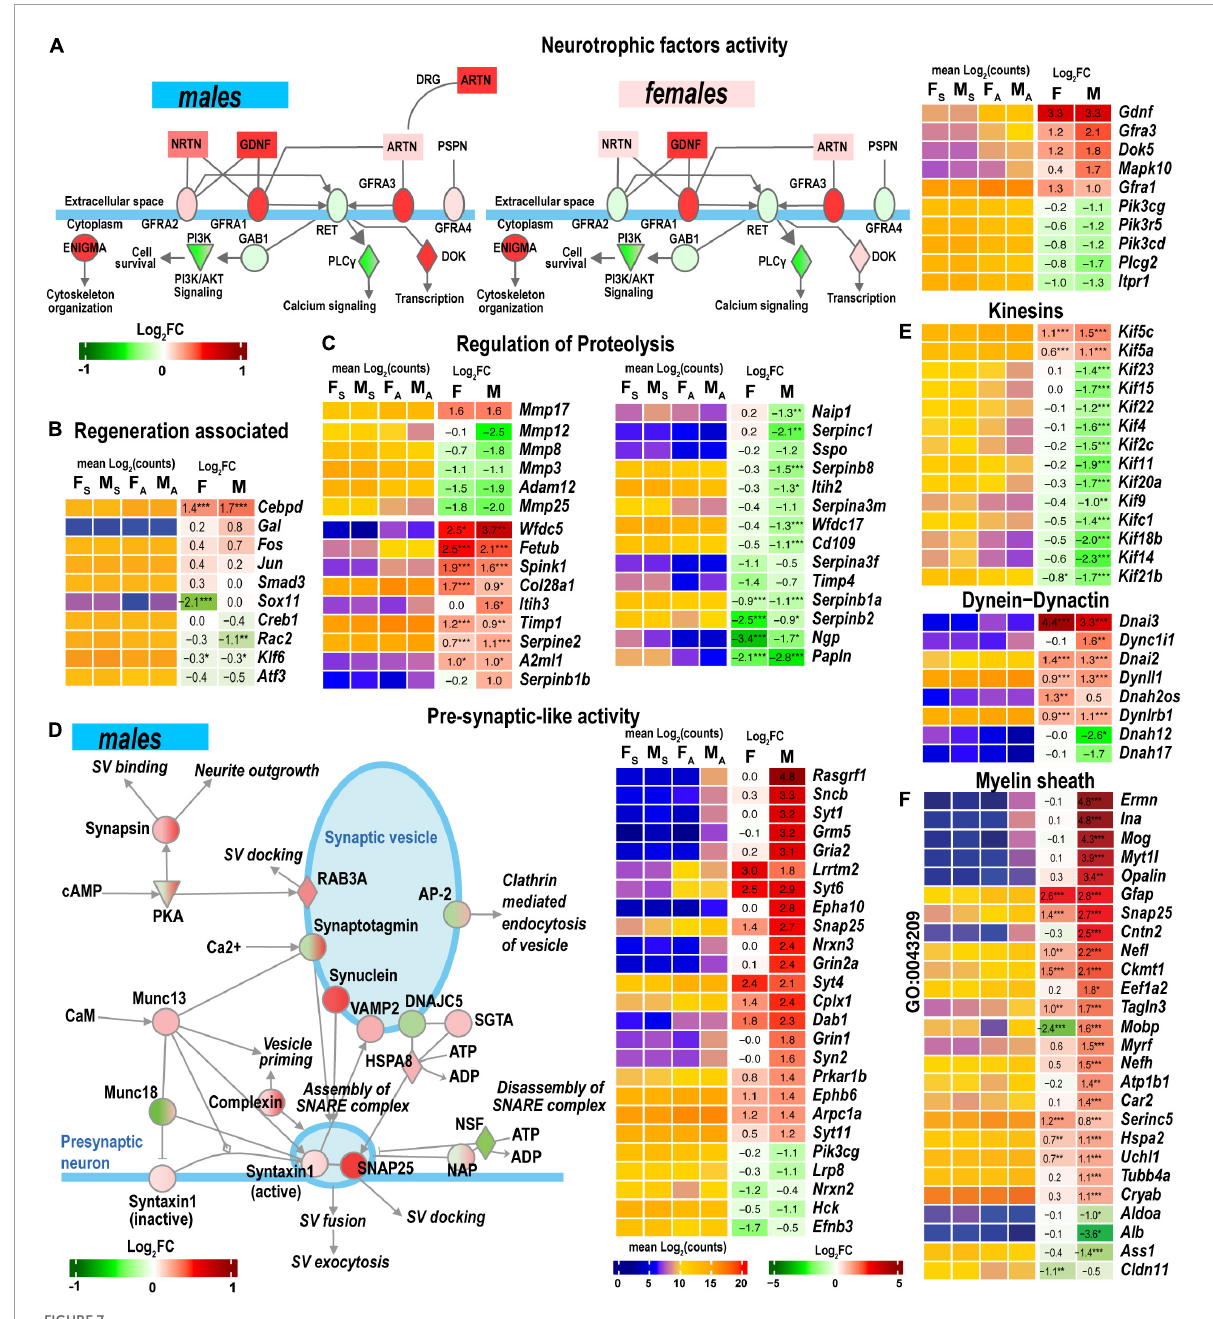
FIGURE7 Nerve regeneration-related signaling and pre-synaptic-like activity exhibited sexually dimorphic activation. (A) glial cell line-derived neurotrophic factor (GDNF) family of ligands can drive the cytoskeleton organization, Pi3k/Akt signaling, Ca 2 + -signaling, and regulate downstream gene transcription. The diagram partially corresponds to the GDNF Family Ligand Receptor Interactions Pathway predicted by Ingenuity Pathway Analysis (IPA). Colors correspond to up- (red) or down- (green) regulation of respective differentially expressed genes (DEGs) according to the Log 2 FC scale. Protein interactive networks were predicted in IPA. (B) Regeneration-associated DEGs. (C) Regulation of extracellular proteolysis-related DEGs. (D) Pre-synaptic-like activity in male nerves. The diagram partially corresponds to the Synaptogenesis Signaling Pathway predicted by IPA. Colors correspond to up- (red) or down- (green) regulation of respective DEGs according to the Log 2 FC scale. (E) Kinesins, dynein-dynactin DEGs. F, Myelin sheath-related DEGs. Heatmaps on panels A–C, E , and F display normalized mean log 2 (counts) in sample groups (F S , female sham; M S , male sham; F A , female axotomy; M A , male axotomy) and log 2 FC in female (F) and male (M); ( n = 6 mice/group, 2 mice/sample (pooled), 3 sample/group) of respective DEGs. Log 2 FC significance was determined in DESeq2 using Wald test: *, p ≤ 0.05; **, p ≤ 0.005; ***, p ≤ 0.0005. DEGs were sorted by log 2